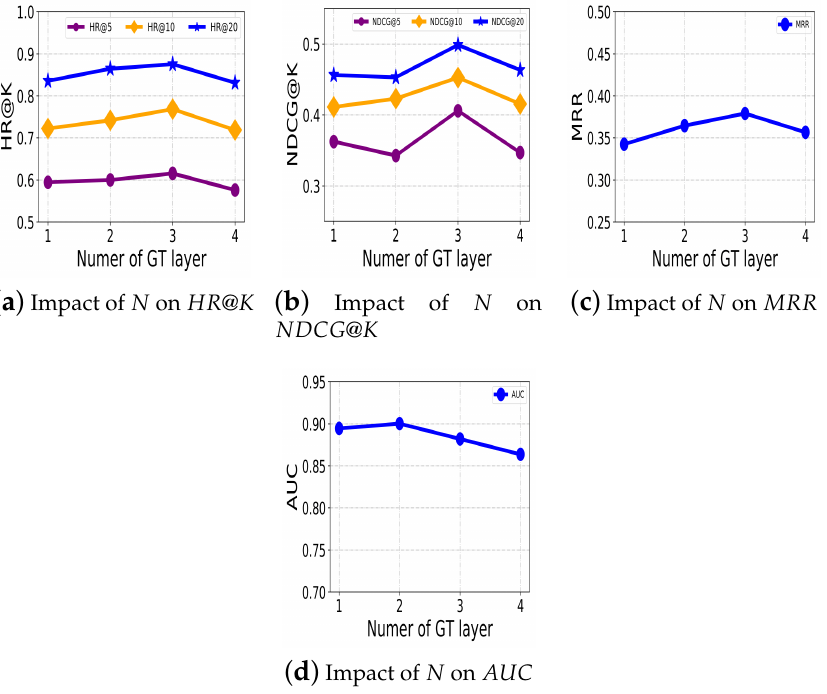
Figure 7. Parameter sensitivity of AGMKRec over the MG layer N .